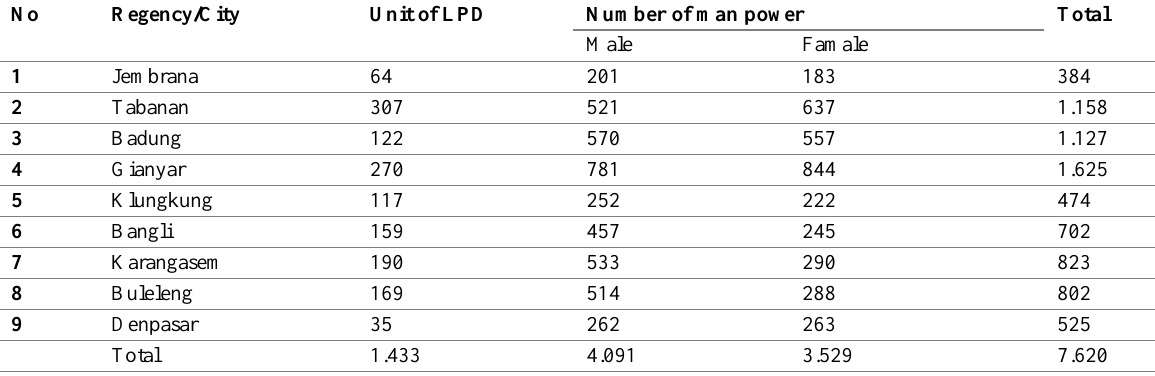
Table 3: Distribution of LPD as Bali and number of